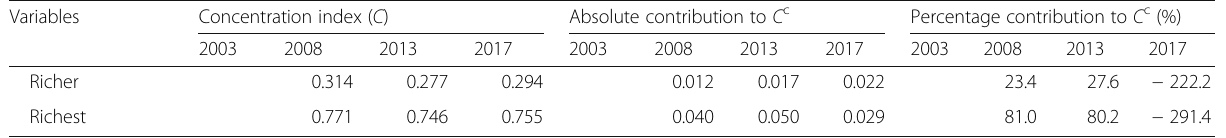
Table 3 Decomposition analysis of inequalities in NHIP a coverage, self-reported illness, and healthcare utilization b among older adults in the Philippines, 2003 – 2017 (Continued)